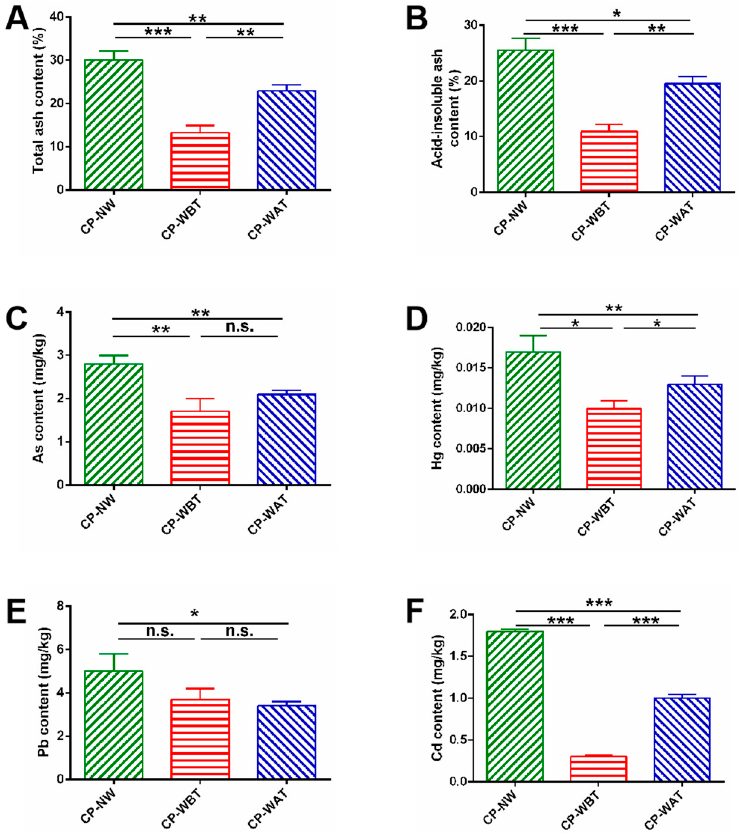
Figure 1. The contents of ash and heavy metals in three kinds of CP samples. ( A ) total ash, ( B ) acid-insoluble ash, ( C ) As, ( D ) Hg, ( E ) Pb, and ( F ) Cd. Data represent means ± SD, n = 3. *** p < 0.001, ** p < 0.01, * p < 0.05.